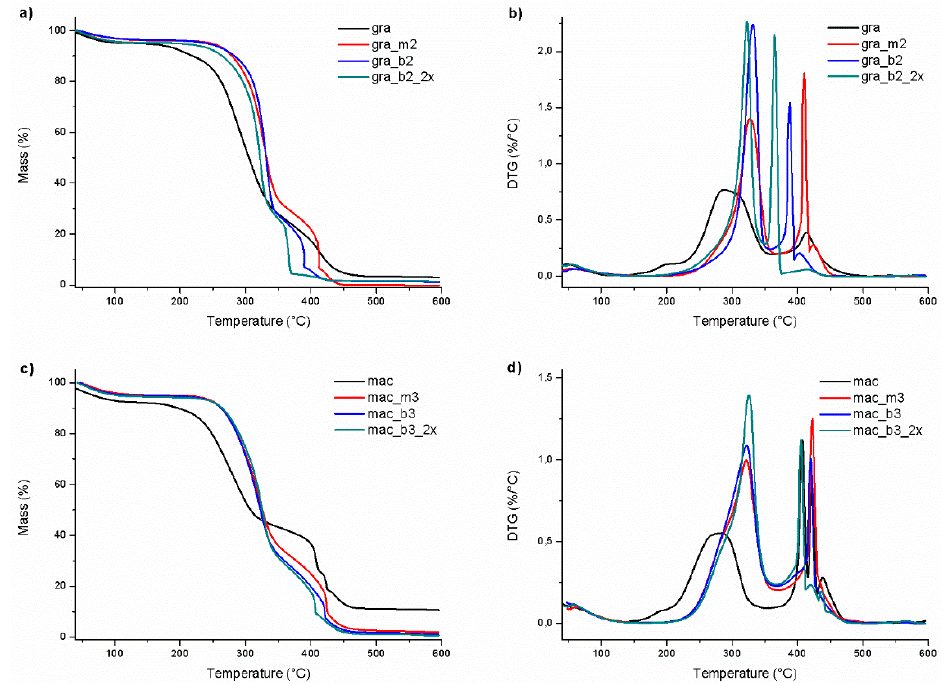
Figure 4. Thermograms (a) TG and ( b ) DTG curves of gravata raw, mercerized and bleached fibers, ( c ) TG and ( d ) DTG curves of macauba raw, mercerized and bleached fibers, in synthetic air atmosphere and heating rate of 10 °C/min.